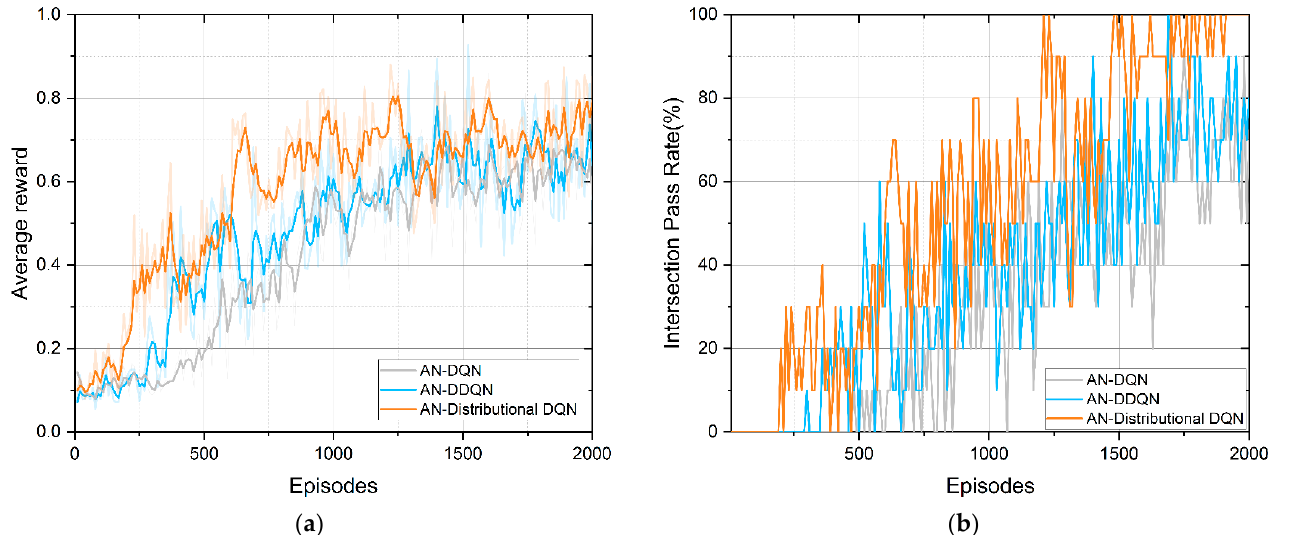
Figure 15. Intersection scenario training results: ( a ) average reward variation for the three methods during training and ( b ) intersection pass rate variation for the three methods during training.